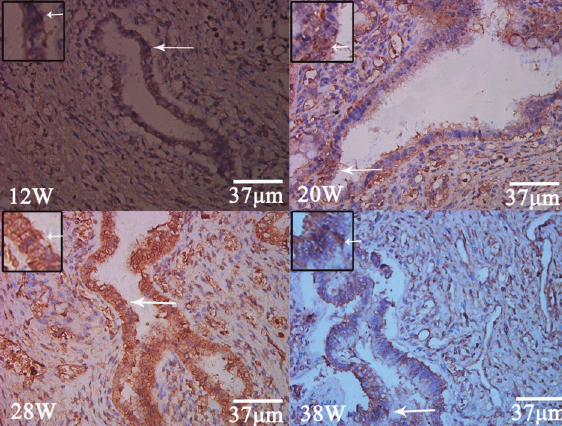
Figure 4. Positive expression of c-myc (arrows) in the common bile duct cells in the cytoplasm and nucleus at different fetal stages (12, 20, 28, and 38